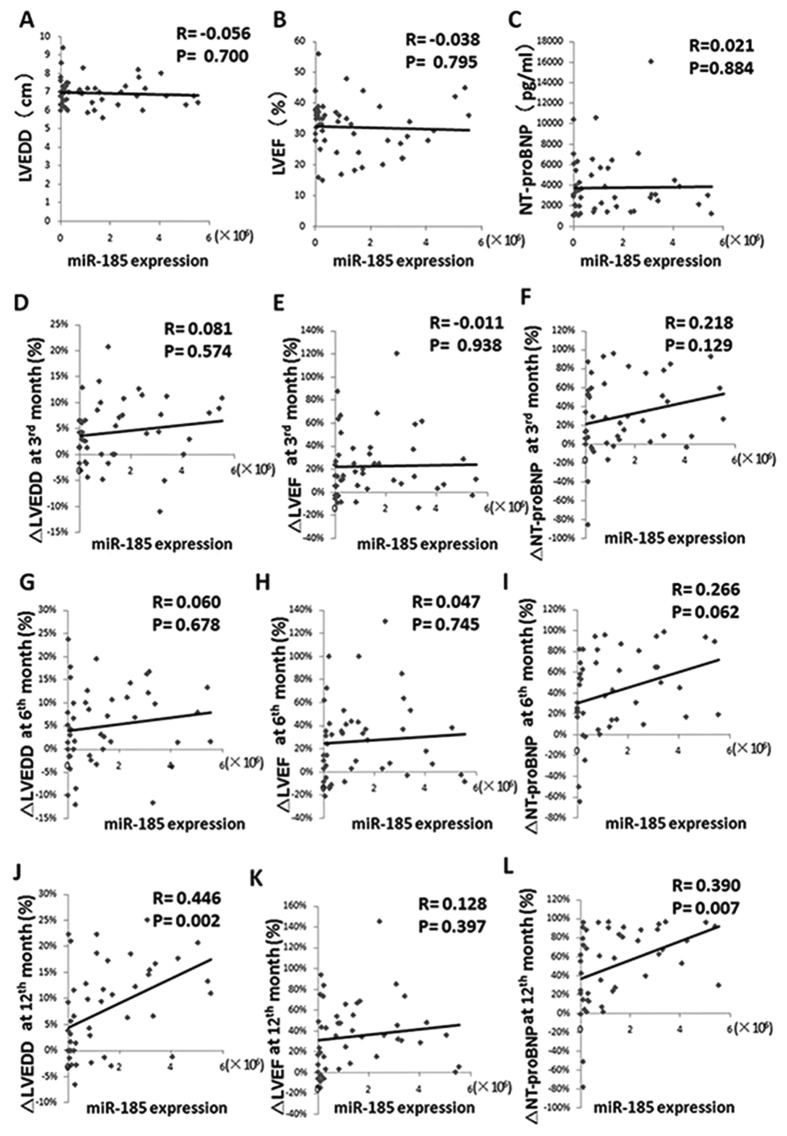
The Correlation of MiR-185 Levels and the Indexes of Cardiac Function in DCM Patients.(A–C) The correlation analysis of miR-185 levels and LVEDD, LVEF and NT-proBNP at month 0 in DCM patients, the correlation index (R) is respectively −0.056, −0.038 and 0.021, all P > 0.05. (D–F) The correlation analysis of miR-185 levels and the reduction rates of LVEDD (R = 0.081), LVEF (R = −0.011) and NT-proBNP (R = 0.218) at 3rd month compared with the baselines at month 0 in DCM patients, all P > 0.05. (G–I) The correlation analysis of miR-185 levels and the reduction rates of LVEDD (R = 0.060), LVEF (R = 0.047) and NT-proBNP (R = 0.266) at 6th month compared with the baselines at month 0 in DCM patients, all P > 0.05. (J–L) The correlation analysis of miR-185 levels and the reduction rates of LVEDD (R = 0.446, P = 0.002), LVEF (R = 0.128, P > 0.05) and NT-proBNP (R = 0.390, P = 0.007) at 12th month compared with the baselines at month 0 in DCM patients. ΔLVEDD = (the baseline LVEDD at month 0- LVEDD in the follow-up period)/the baseline LVEDD at month 0, ΔLVEF = (LVEF in the follow-up period-the baseline LVEF at month 0)/the baseline LVEF at month 0, and ΔNT-proBNP = (the baseline NT-proBNP at month 0- NT-proBNP in the follow-up period)/the baseline NT-proBNP at month 0.